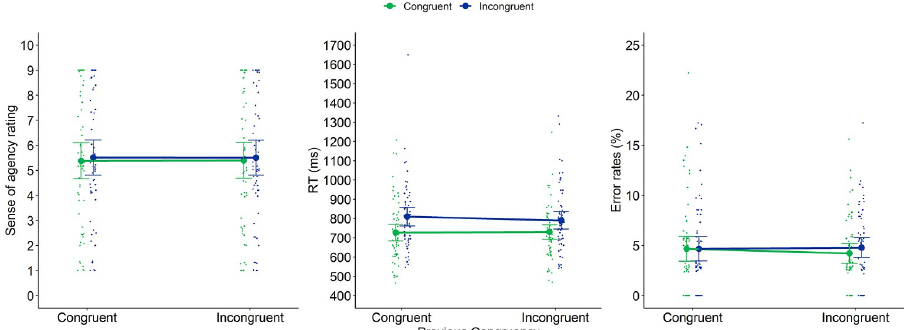
Fig 6. Sense of agency ratings (left panel), RTs (middle panel) and error rates (right panel) of Experiment 2 as a function of Block and current congruency. Dots represent mean RTs for each participant in each condition (thus, each participant is depicted four times on this graph, once for each Block × Current Congruency condition). Error bars represent 95% confidence